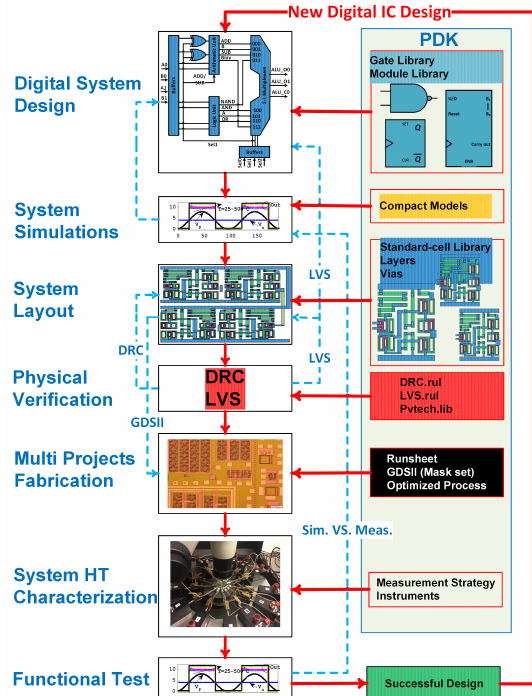
Figure 4. The feedback provided by the digital ICs HT characterization, simulations, design and fabrication is highlighted by blue arrows (dotted lines), whereas the right hand side box containing small boxes shows the PDK contents and is used to design the digital circuits. The red arrows and boxes indicate steps of digital ICs realization using SiC TTL PDK. The digital ICs were modeled at behavioral level and structure level using ISE tools such as ModelSim, Matlab, and Quartus II. After that The digital circuits were implemented at transistor level in the Cadence Virtuoso IC design environment using the PDK gate and module library. The transistor level simulations were carried out using the high-temperature compact models. The circuit layout implementation was carried out using the standard cell library. To ensure the in-house standards the physical verification was done using DRC and LVS programs in the Cadence supported PVS tool. The GDSII file was generated to order the masks set. The process runsheet with masks set and SiC wafers were used and circuits were fabricated in our SiC low voltage technology. The fabricated circuits were measured on the wafer. The feedback provided by the characterization of the digital ICs has been used for the functional verification, process optimization and PDK